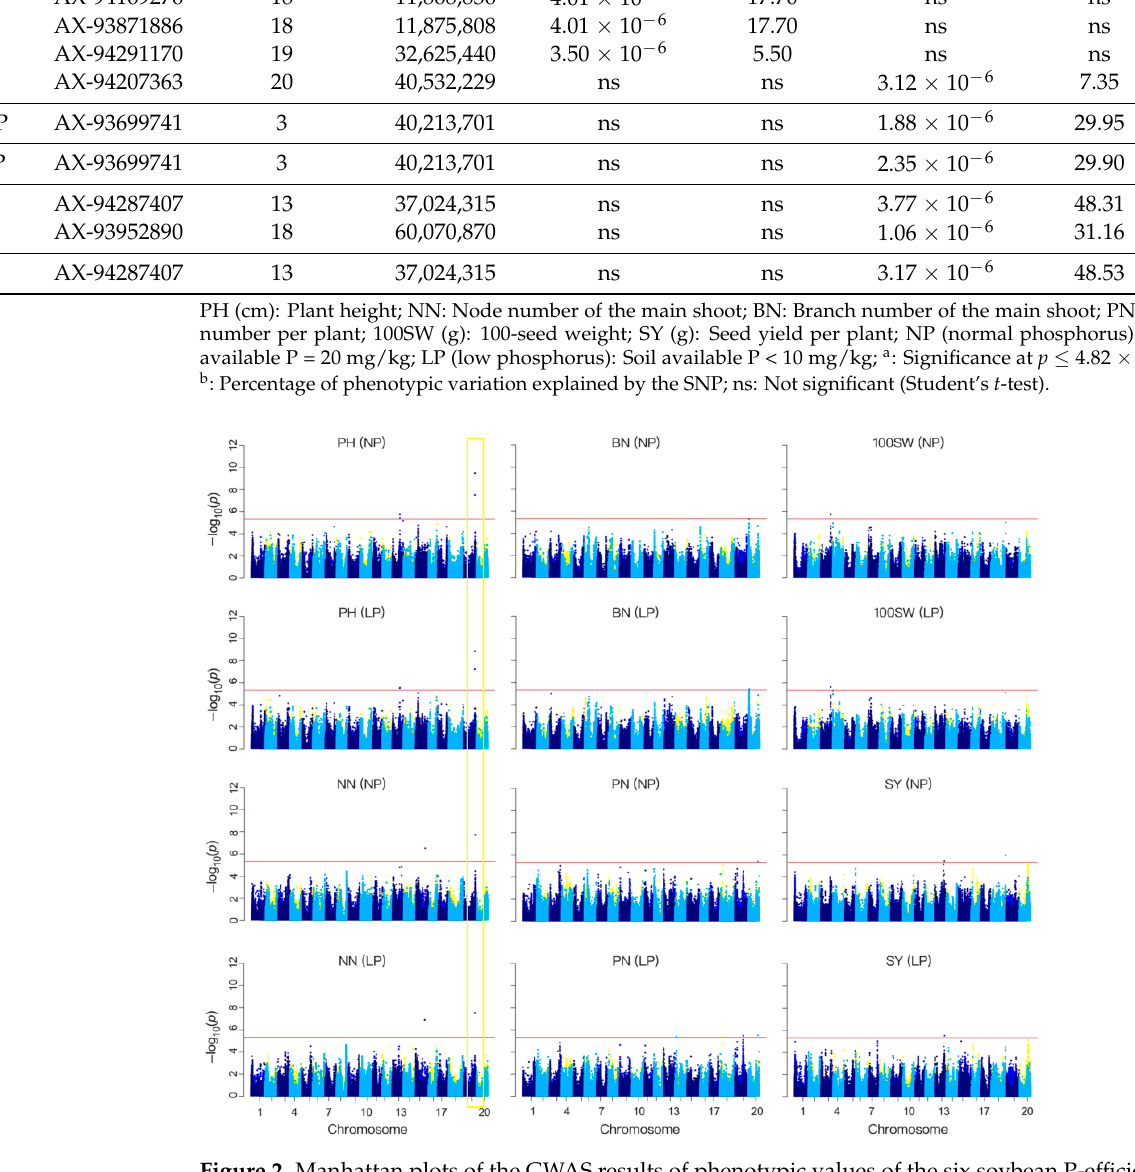
Figure 2. Manhattan plots of the GWAS results of phenotypic values of the six soybean P-efficiency- related traits at maturity under NP and LP conditions in E1 and E2. PH (cm): Plant height; NN: Node number of the main shoot; BN: Branch number of the main shoot; PN: Pod number per plant; 100SW (g): 100-seed weight; SY (g): Seed yield per plant; NP (normal phosphorus): Soil available P = 20 mg/kg; LP (low phosphorus): Soil available P < 10 mg/kg; the red lines indicate the significant threshold ( − log 10 ( p ) = 5.32); the colours purple and yellow indicate E1; the colours dark purple and blue indicate E2; the yellow box indicates SNPs AX-93897192 and AX-93897200 located on chromosome